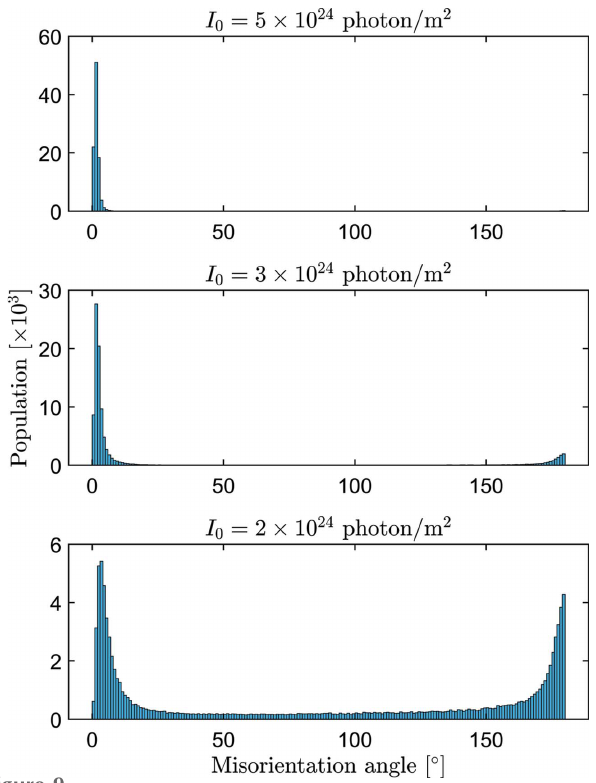
Figure 9 Distribution of the misorientation angle for the converged results of the EMC method at three different XFEL pulse fluences (indicated at the top of the panels) for RNA polymerase